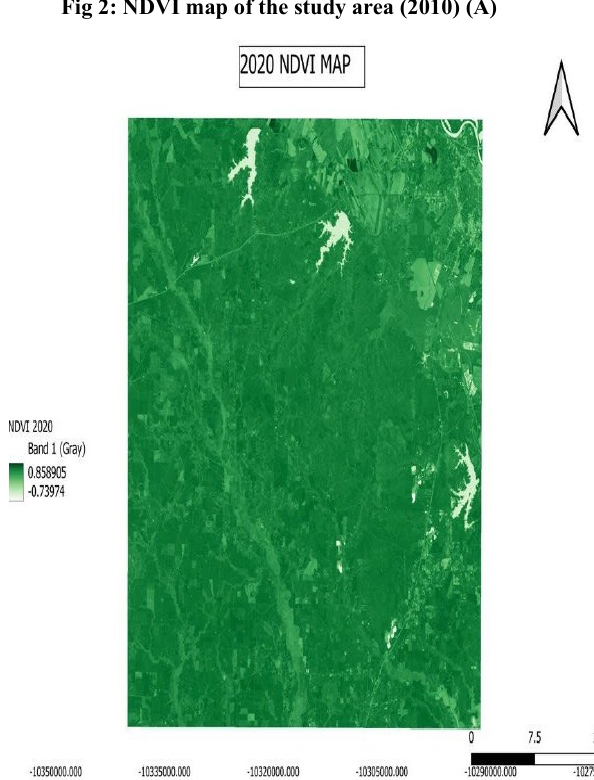
Fig 3: NDVI map of the study area (2020) (B)